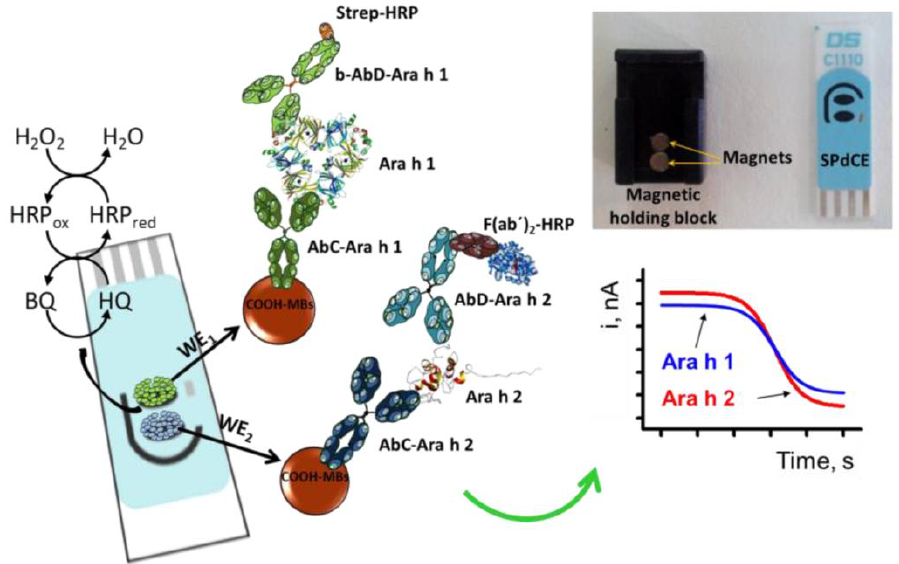
Figure 4. Principle of the simultaneous determination of Ara h 1 and Ara h 2 using screen-printed dual carbon electrodes and amperometric detection. A real picture of the SPdCE and the homemade magnetic holding block is also shown. Reprinted from [90] under Creative Commons Attribution (CC-BY) license (http://creativecommons.org/licenses/by/4.0/).